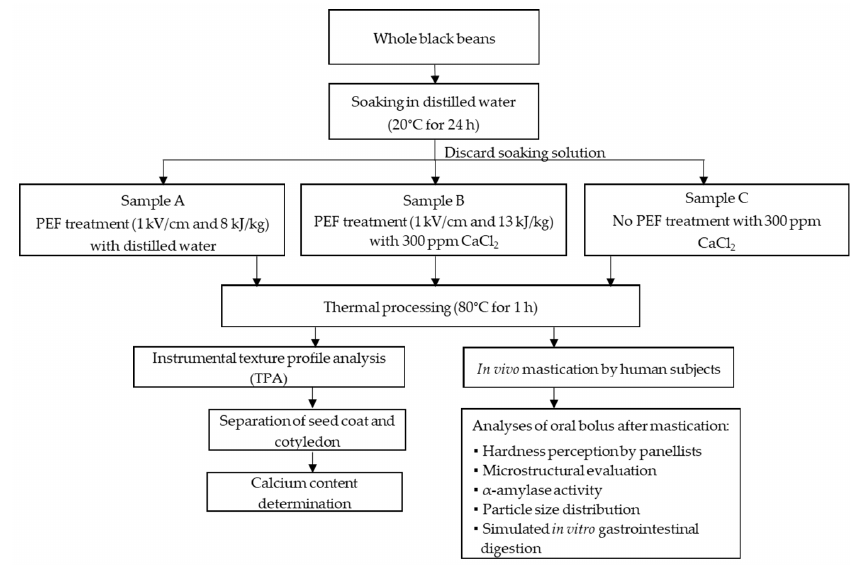
Figure 1. Experimental setup of this study. (PEF: Pulsed electric field)